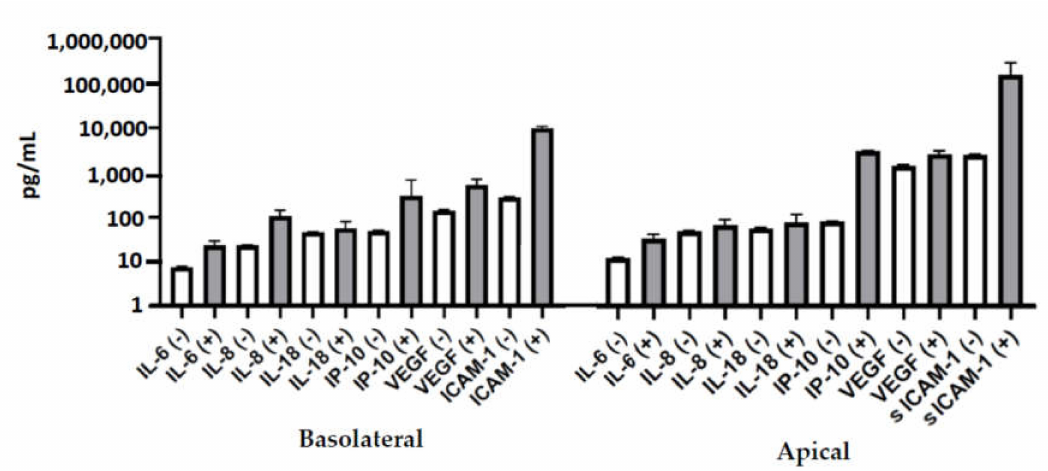
Figure 5. Cytokine concentrations (pg / mL) in the basolateral and the apical medium of Caco-2 cells without (white bars “( − )”) or with (grey bars “( + )”) 24 h treatment with an inflammatory cocktail on the basolateral